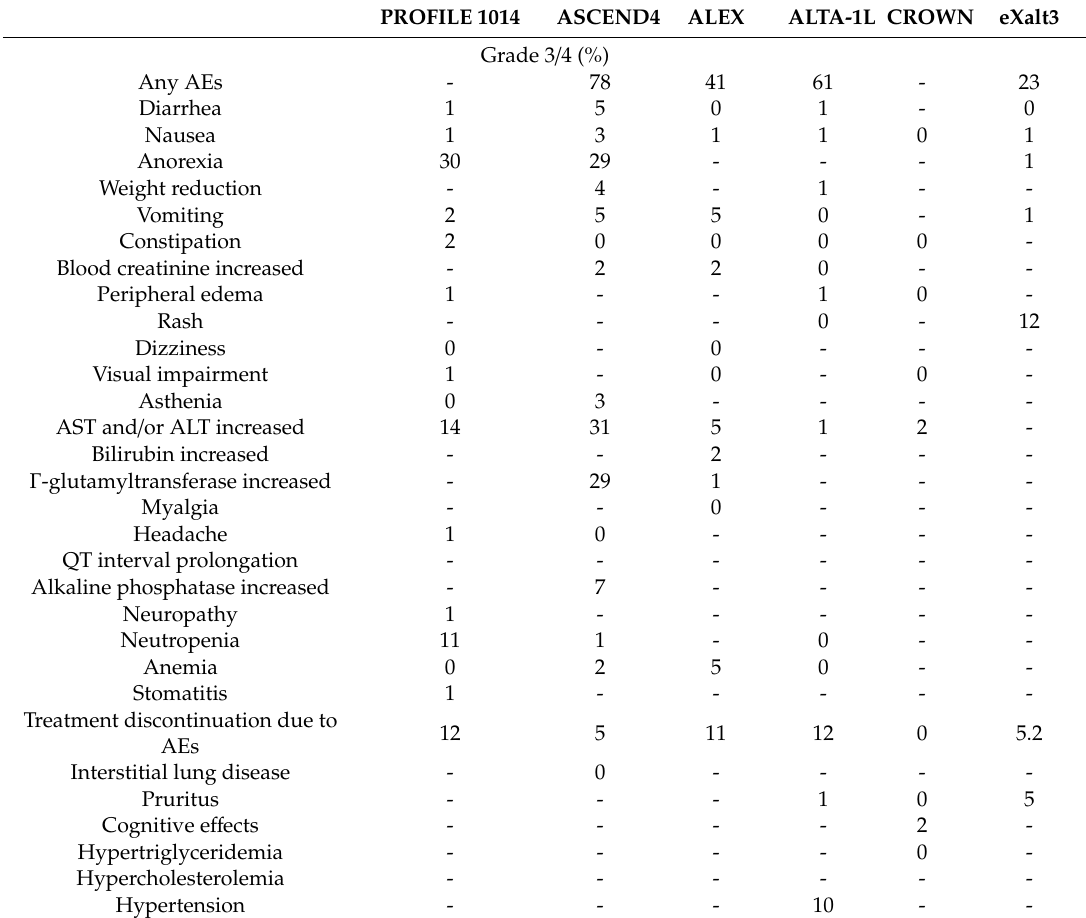
Table 3. Summary of principal adverse events (AEs) observed during phase III trials in the first-line setting ALK-positive